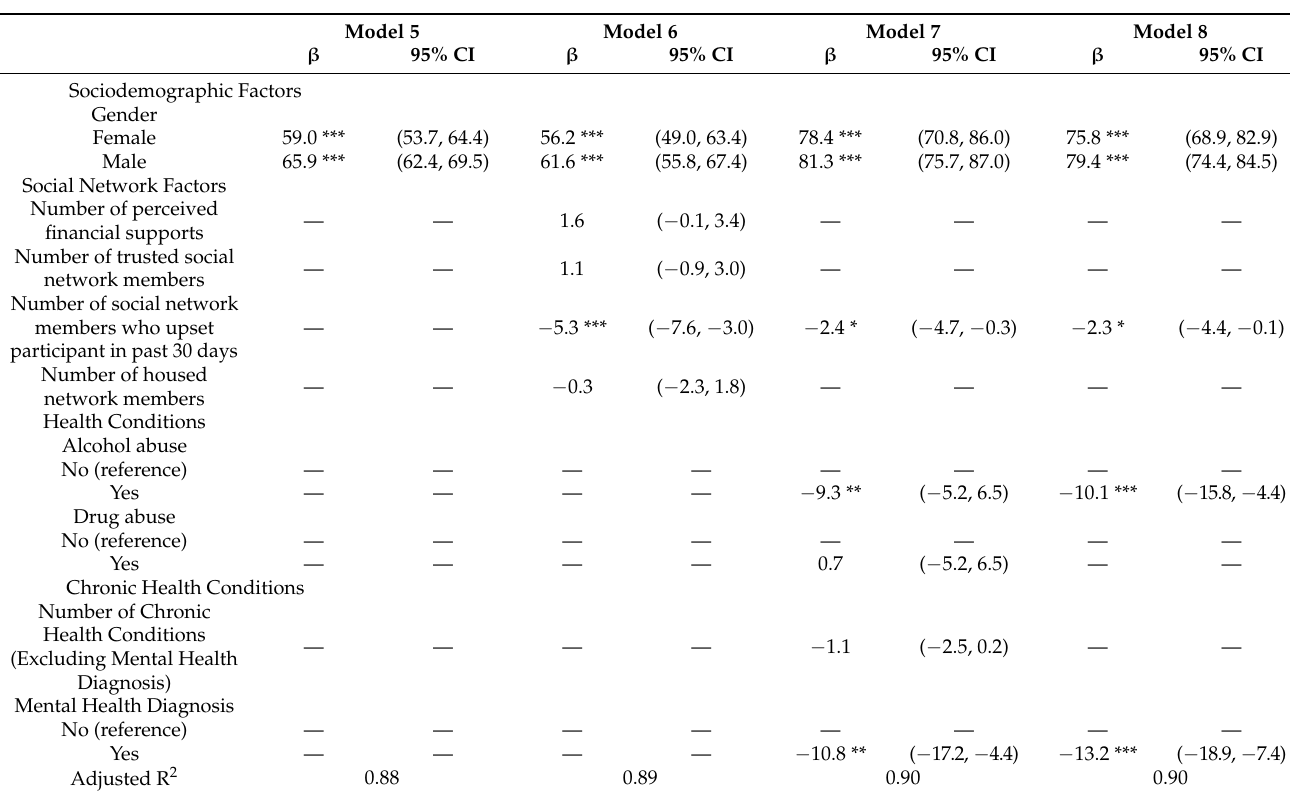
Table 8. Fixed-effects stepwise linear regression models exploring associations between gender, social network factors, substance use, and chronic health conditions on emotional well-being scale score